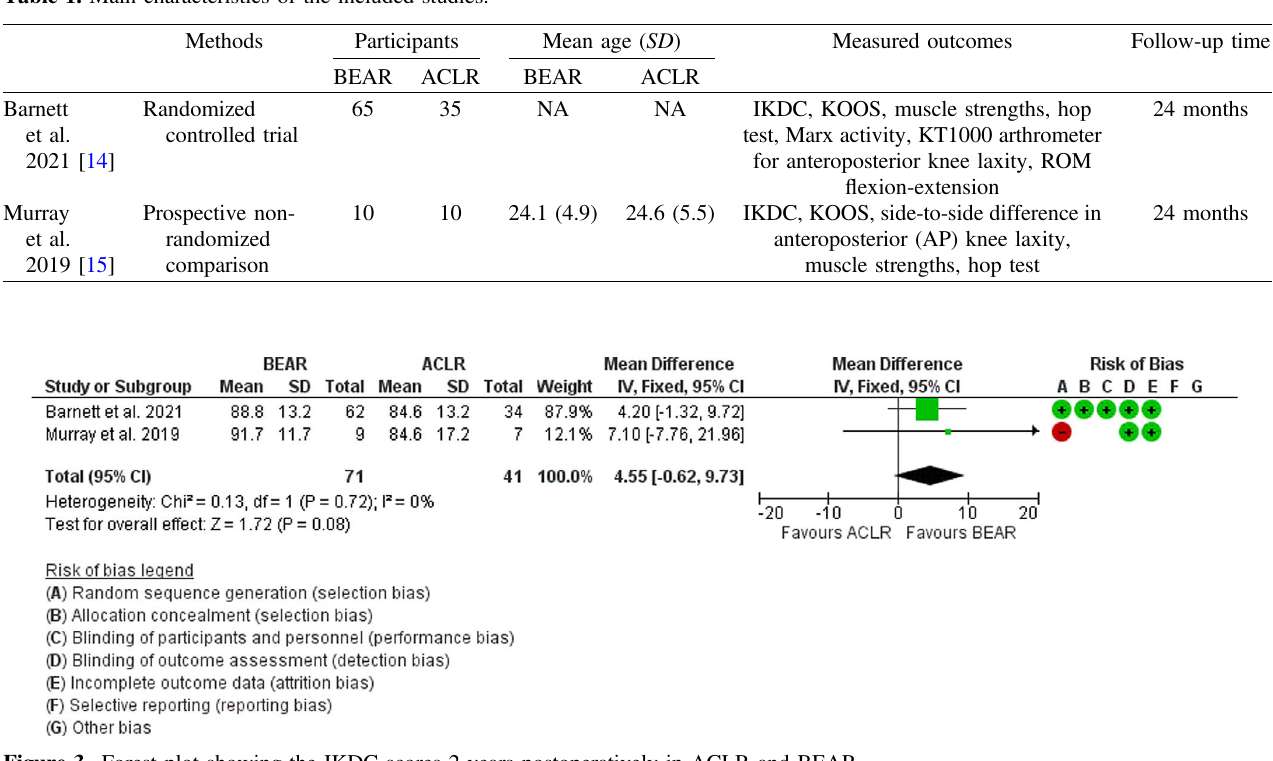
( p = 0.51, Mean difference = 1.27; 95% CI: (cid:3) 2.51 to 5.05, Figure 4C), activities of daily life ( p = 0.56, Mean differ- ence = 0.58; 95% CI: (cid:3) 1.36 to 2.53, Figure 4D), and sports and recreation ( p = 0.28, Mean difference = 3.83; 95% CI: (cid:3)